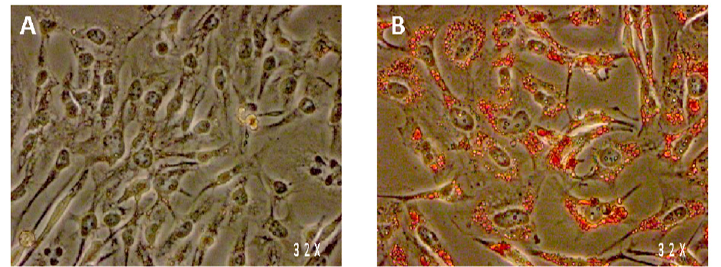
Figure 1. Intracellular lipid content (Oil-red-O staining) of SW 872 cells after 7 days of incubation without any treatment ( A ) or with 100 µM oleic acid ( B